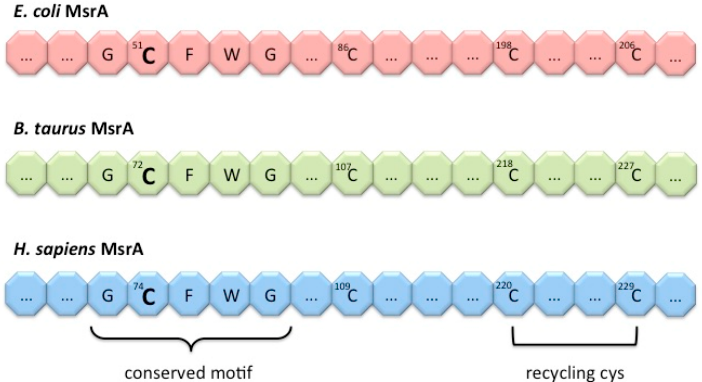
Figure 3. MsrA conserved GCFWG motif. Schematic representation of the conserved MsrA active-site sequence in E. coli , B. Taurus and H. sapiens , where the respective conserved cysteine is placed: Cys-51 in the case of bacterial MsrA, Cys-72 for bovine MsrA and Cys-74 in human MsrA. Three other cysteine residues were shown to be conserved: bacterial Cys-86, Cys-198 and Cys-206; bovine Cys-107, Cys-218 and Cys-227; and human Cys-109, Cys-220 and Cys-230; with the two last cysteines, toward the C-terminus of each MsrA, being responsible for recycling of the catalytic cysteine.